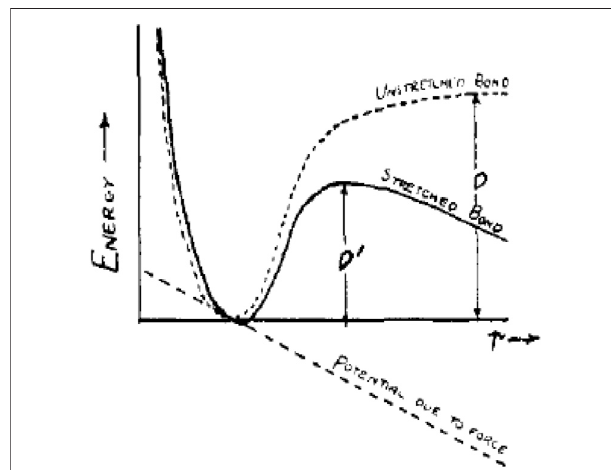
FIGURE 3 | Potential function for the bond given by a Morse function. Whenthebondisundertensionduetoaconstantforce f pullingoneitherend, the activation energy required to break the bond is diminished from D to D ′ (Kauzmann and Eyring, 1940). (X-coordinate stands for the length of the bond, r , while the Y-coordinate stands for “ energy. ” The dotted and solid curves represent “ unstretched bond ” and “ stretched bond, ” respectively. The dotted straight line represents “ potential due to force ” ).